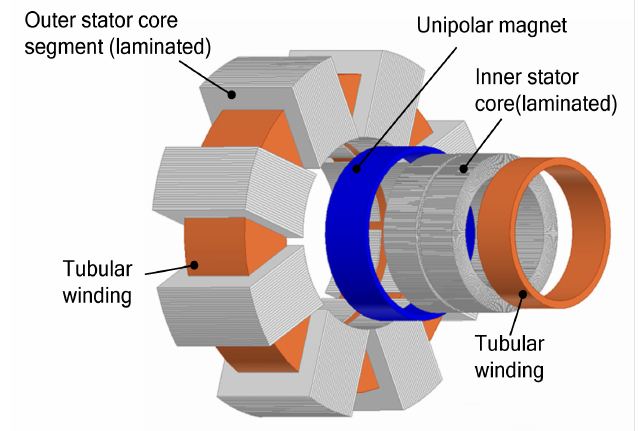
Figure 2. Configuration of the proposed model